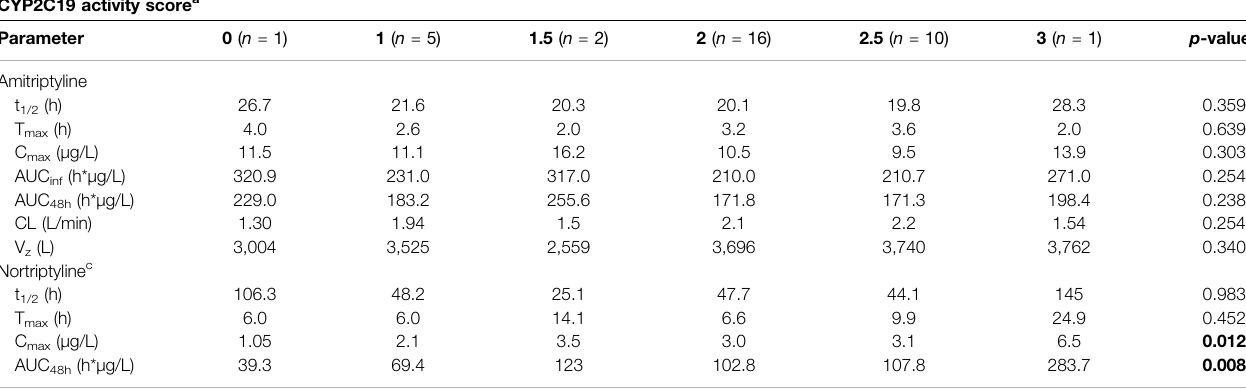
TABLE 4 | Pharmacokinetic parameters strati fi ed by CYP2C19 genotype. CYP2C19 activity score a Parameter